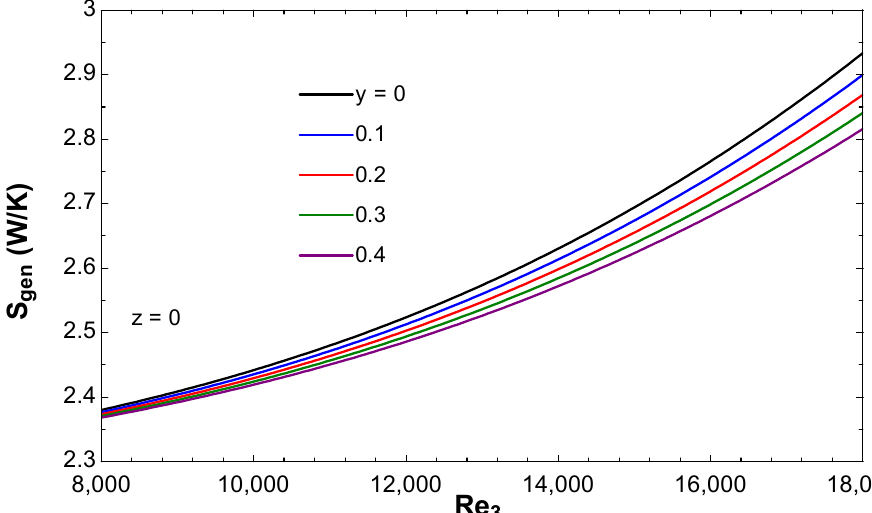
Figure 12. Effect of airflow ratio y and Reynolds number on entropy generation. From the above parametric study, it can be seen that the Reynolds number and airflow ratios had opposite effects on collector efficiency and entropy generation. The maximum efficiency was achieved at a certain Reynolds number and at certain airflow ratios in the surveyed range. Meanwhile, entropy generation increased with the increase of Re and decrease of flow ratios. Therefore, to assign optimal values of independent parameters, a Pareto front was constructed, as shown in Figure 13. The Pareto front curve was established using the genetic algorithm with the settings shown in Table 4. The curve was a series of optimal solutions that yielded a large efficiency and small entropy generation. Ideal and non-ideal points located at the vertices of the rectangle formed by the Pareto curve were found. To determine the final solution, the TOPSIS decision-making technique was applied, which found S gen = 2.4691 W/K and η eff = 65.38%, as shown in the graph. This is the point that was closest to the ideal point (bottom-right corner) and furthest from the non-ideal point (top-left corner). The optimal parameters at the selected point were found to be Re 3 = 11,156, y = 0.258, and z = 0.036. In addition, Figure 13 also shows the maximum efficiency value corresponding to the maximum entropy generation and vice versa.